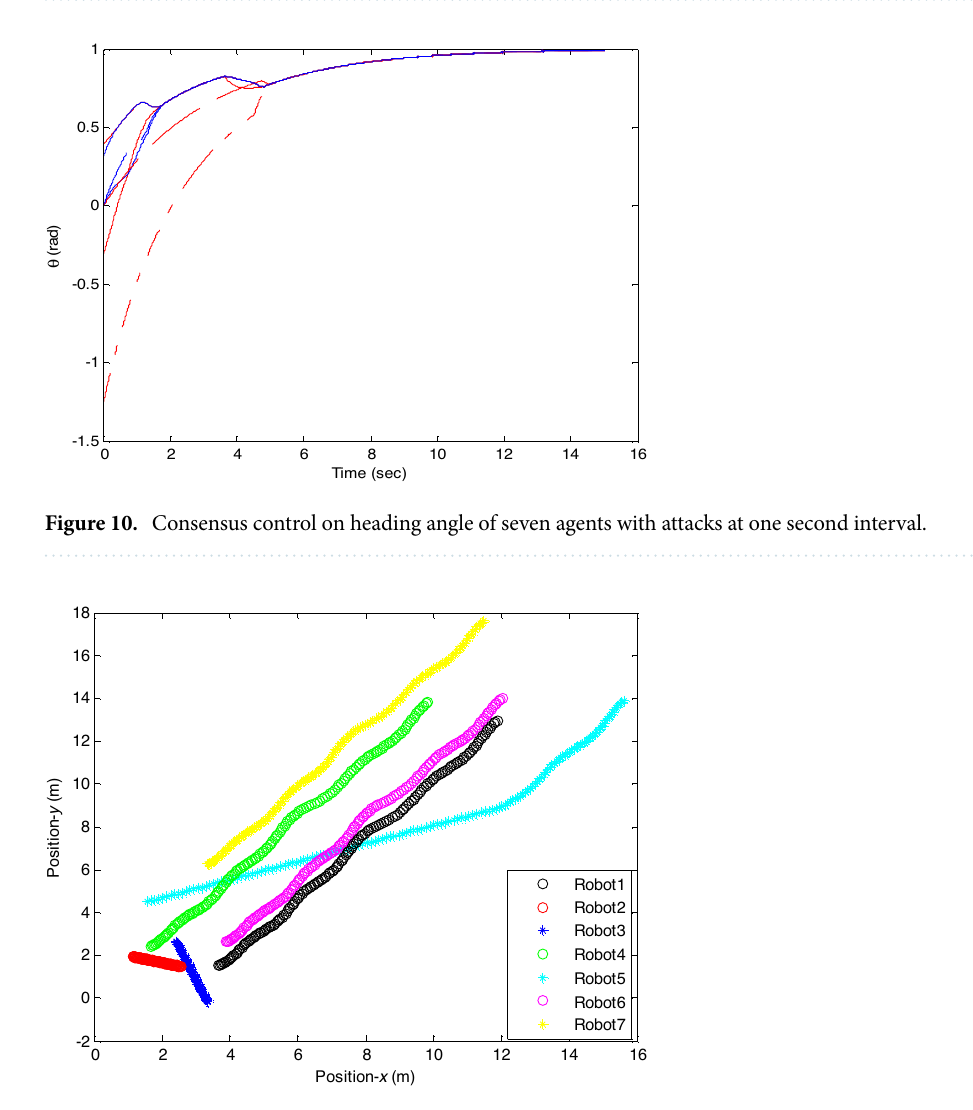
Figure 11. Consensus control of seven